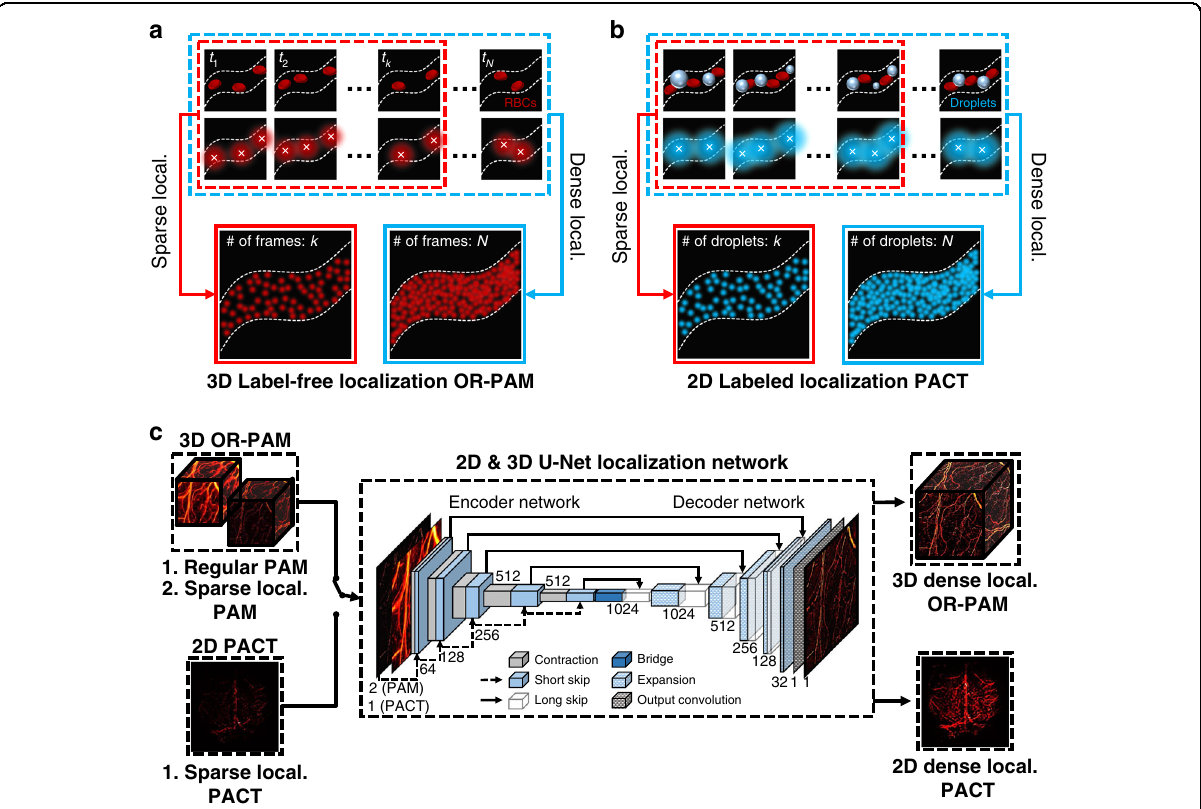
Fig. 1 Overview of 3D-2D hybrid deep-learning localization imaging. Acquisition of localization a OR-PAM dataset and b PACT dataset. Dense localization-based images are generated using N frames in OR-PAM or N dye droplets in PACT. A sparse localization-based image is constructed using k randomly selected images in OR-PAM or k droplets in PACT (k < N). c Visual representation of the customized 2D and 3D U-Net generator network architecture. Either 3D sparse localization-based and regular OR-PAM images or a 2D sparse PACT localization image are fed as inputs to the generator. OR-PAM optical-resolution photoacoustic microscopy, PACT photoacoustic computed tomography, Sparse local. sparse localization-based, Dense local. dense